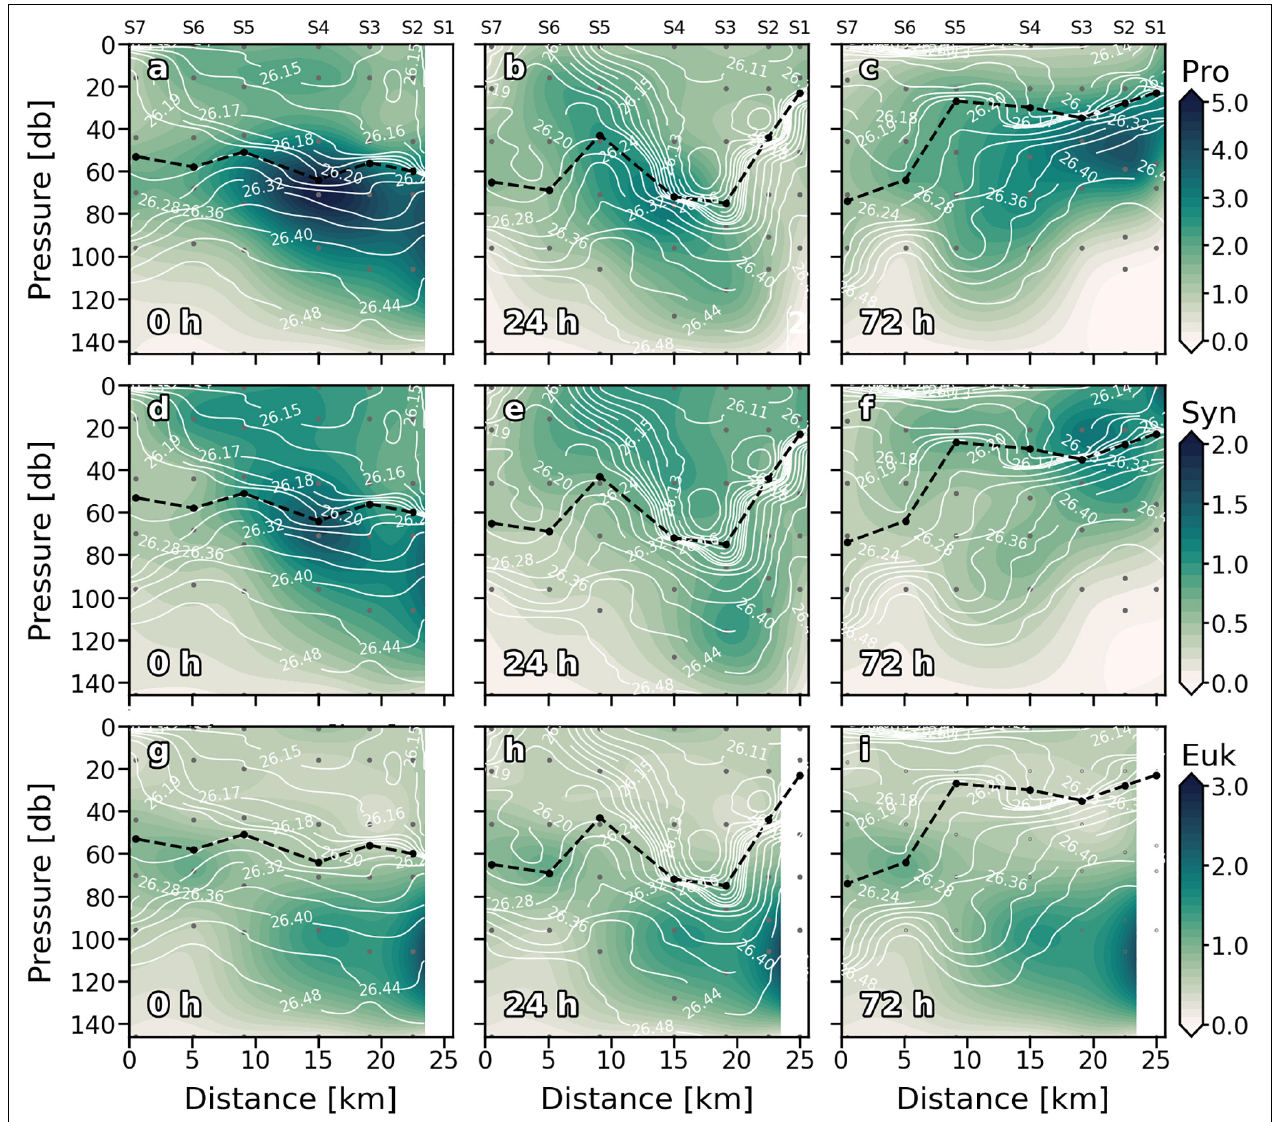
FIGURE 5 | Vertical sections of phytoplankton biomass (mg C · m − 3 ) of Prochlorococcus sp. (Pro) (a–c) ; Synechococcus sp. (Syn) (d–f) and Eukaryotes (Euk) (g–i) for every sampling day. Stations are indicated in the upper part of the plot. Isopycnal field is superimposed as solid white lines. Dashed black line indicates the mixed layer depth. Sampling depths are represented by gray